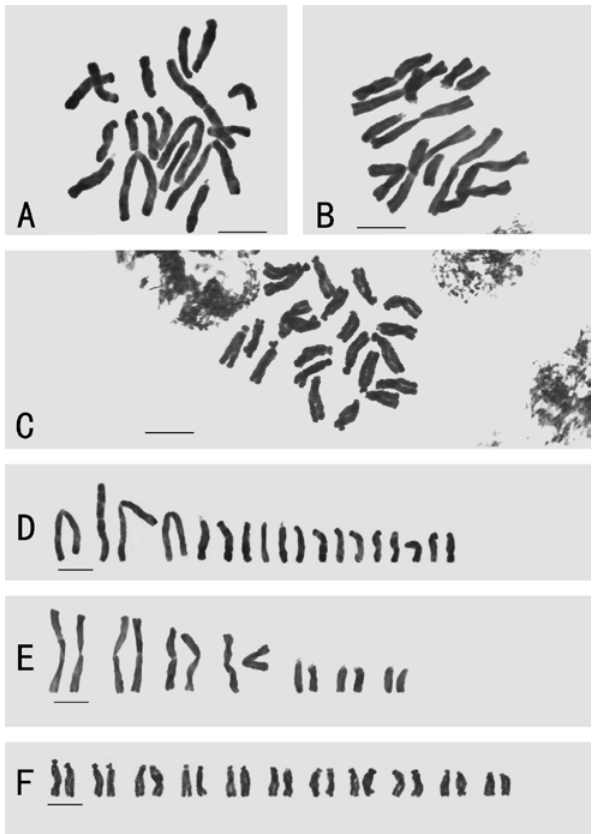
Fig 2. The metaphase chromosome morphology and karyotypes of the putative natural hybrid, Lycoris aurea and L . radiata . A, D: the putative natural hybrid; B, E: L . aurea ; C, F: L . radiata . Scale bar = 10 μm.